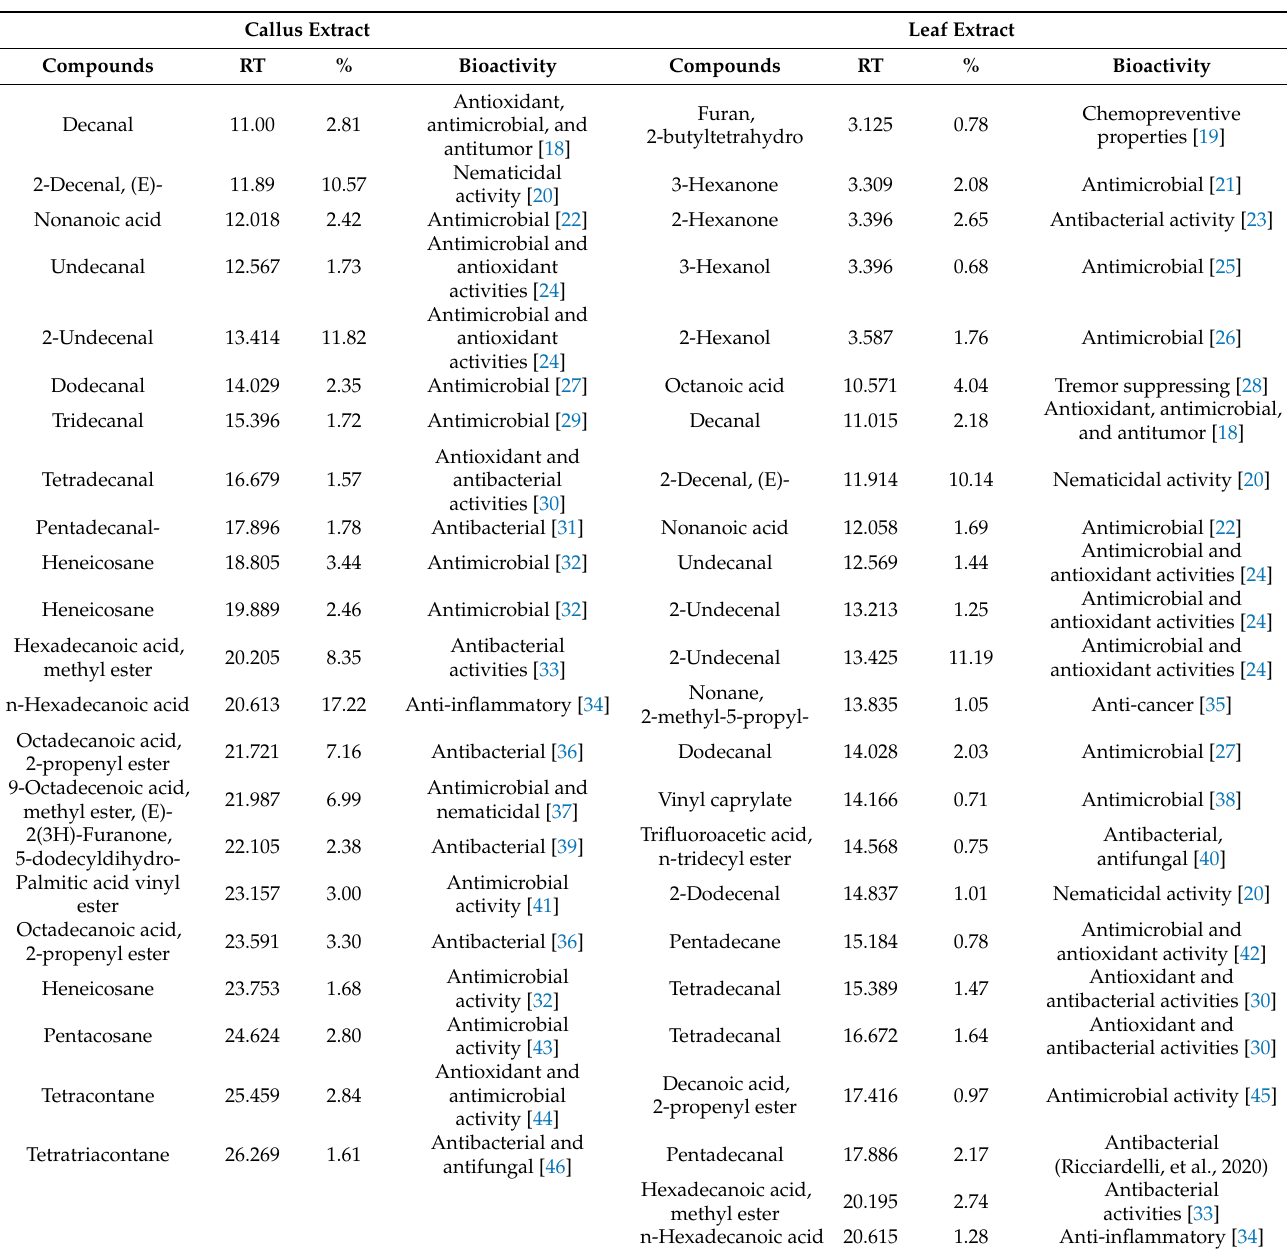
Table 2. Phytocompounds of callus and leaf extracts identified by GC-MS